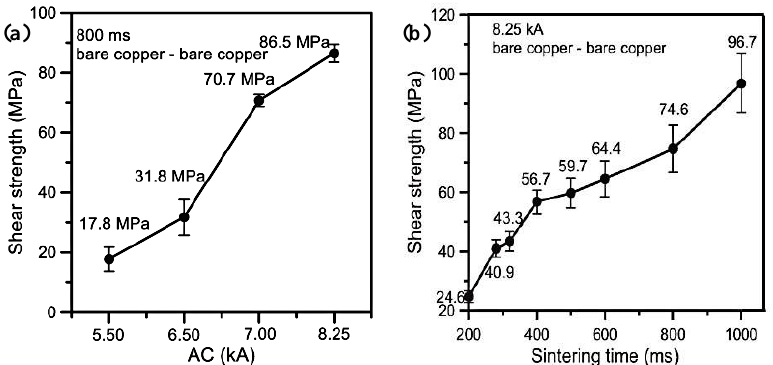
Figure 7. Comparison of shear strength: ( a ) Alternating Current (AC); ( b ) sintering time. Reproduced with permission from [161].